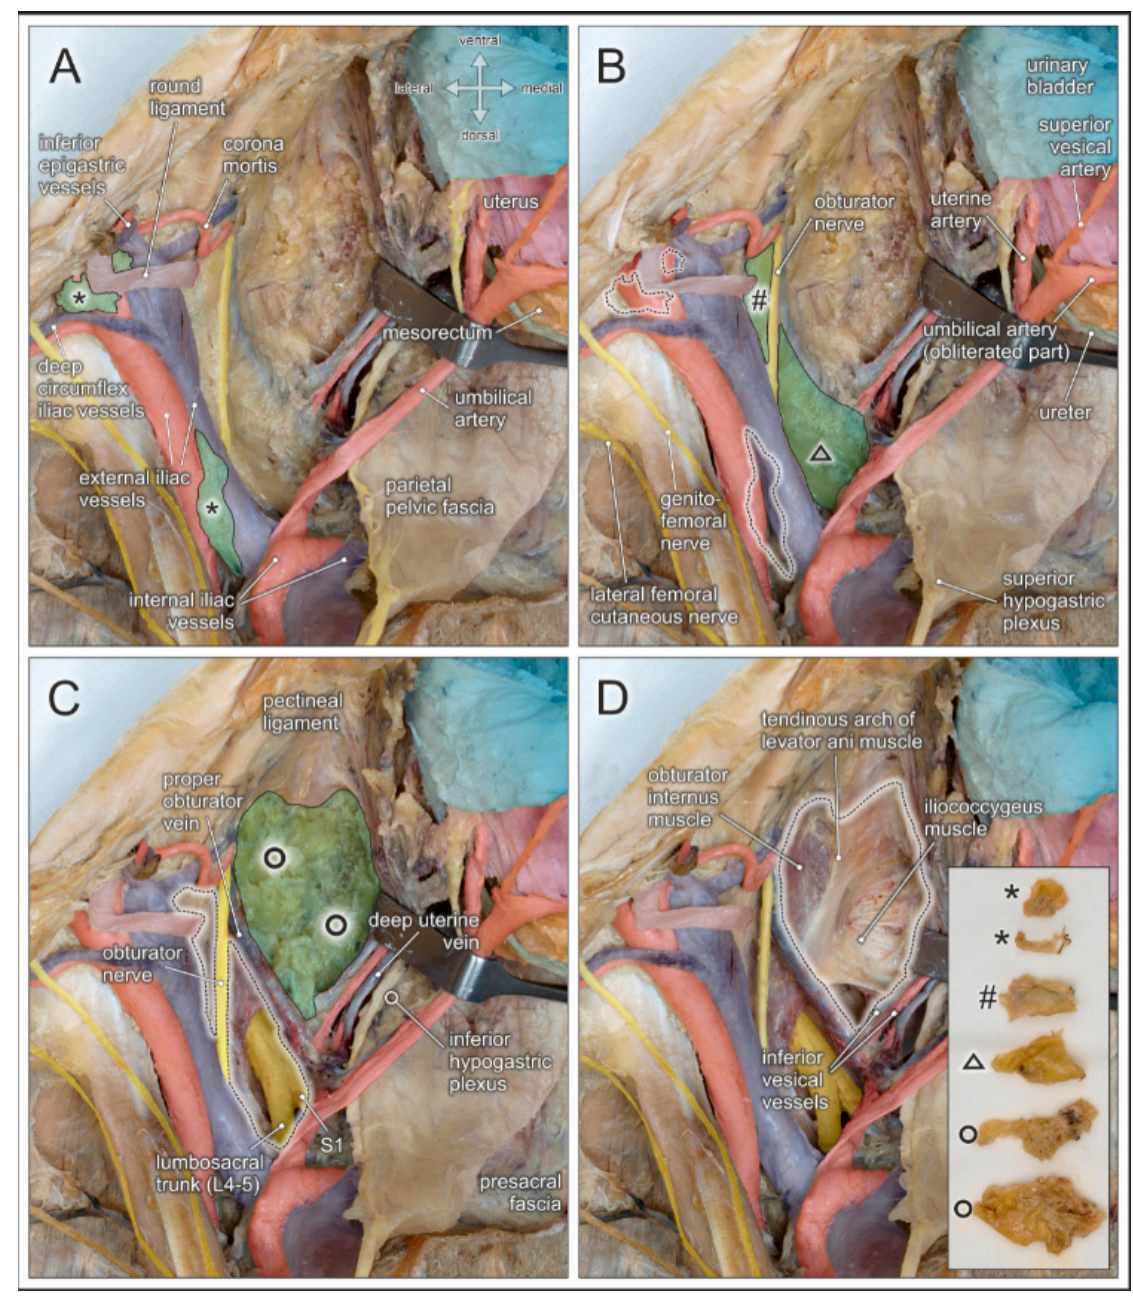
Figure 4. Topographic anatomy and stepwise pelvic lymphonodectomy. Dorsocranial view of a left female pelvis. Pelvic organs (urinary bladder, uterus, rectum, ureter) and their blood vessels are shifted to the right side (hook), and the round uterine ligament is transected. Regional lymph nodes are highlighted in green and dotted black lines after removal. ( A ) Distal and proximal external iliac lymph nodes (asterisks) are located in the vicinity of the deep circumflex iliac vessels, the corona mortis, and the genitofemoral nerve. ( B ) Lymph nodes of the obturator fossa (hashtag) are closely related to the obturator nerve and vessels, and the corona mortis. Presacral lymph nodes (triangle) extend along the sacral concavity and cover the sacral spinal nerves and the lumbosacral trunk (depicted in C after removal). ( C ) Paravisceral/paravesical lymph nodes (circles) are located between the pelvic sidewall and the urinary bladder, extending along the surface of the levator ani muscle. ( D ) Complete removal of pelvic lymph node regions with exposure of relevant anatomical structures at risk of potential injury during pelvic lymphonodectomy. Insert shows the lymphatic tissue harvested from the regions indicated in ( A – C ).